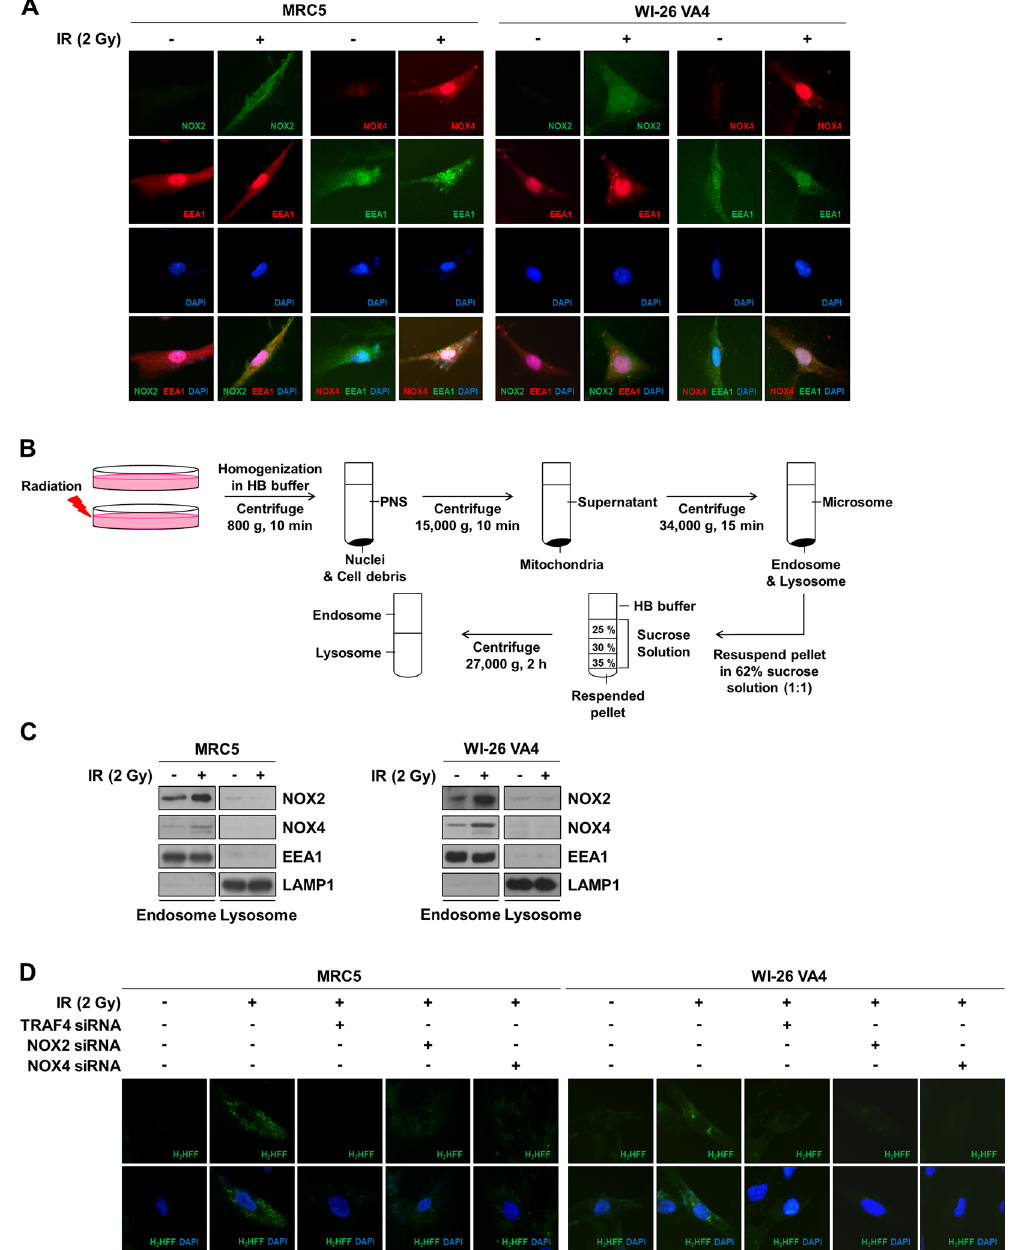
Figure 2. NOXs were localized in endosomes and produced ROS. ( A ) Radiation-induced subcellular localization of NOX2 and NOX4 were visualized by immunocytochemistry. EEA was used as an endosome biomarker. ( B ) An experimental scheme for endosome/lysosome fractionation was described. After irradiation, flotation-gradient fractionation was performed to isolate endosomes and lysosomes. ( C ) Protein levels of NOX2 and NOX4 in endosomes and lysosomes were investigated by Western blotting. After irradiation (2 Gy, 4 h), fractions for endosomes or lysosomes were prepared through flotation-gradient fractionation of cell lysates. Protein levels of NOX2 and NOX4 were measured by Western blotting in endosomal and lysosomal extracts. ( D ) The effects of knockdown of TRAF4, NOX2, or NOX4 on endosomal ROS were visualized with treatment of fluorescent dye H 2 HFF-BSA